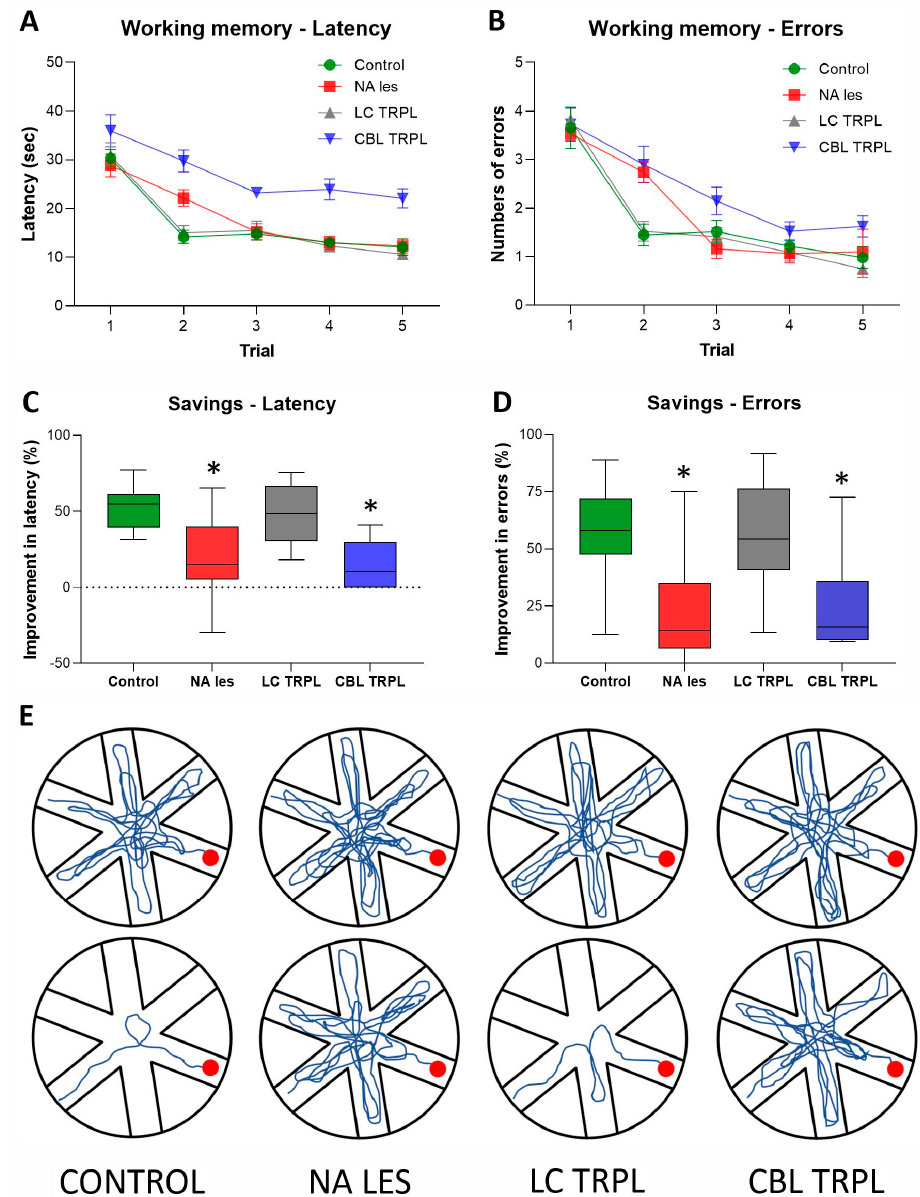
Figure 3. Working memory performance in the Radial Arm Water Maze task performed about 34 weeks post-lesioning and grafting. The latency ( A ) and the number of entry errors ( B ) required by the animals to locate the hidden platform are illustrated. Sample points represent the mean latency and errors ± SEM recorded during each of 60 s trials over five consecutive testing days. In the lower diagrams, performances are plotted as percentage improvement (savings) between trials 1 and 2 for latency ( C ) and errors ( D ). In ( E ), the actual swim paths taken by representative rats from the different groups are illustrated. Note the marked impairments in the Lesioned and CBL-transplanted animals, and the near-normal performance of LC-transplanted animals, with respect to Control. The asterisk indicates a significant difference between the Control and LC-Transplanted groups at p < 0.01.